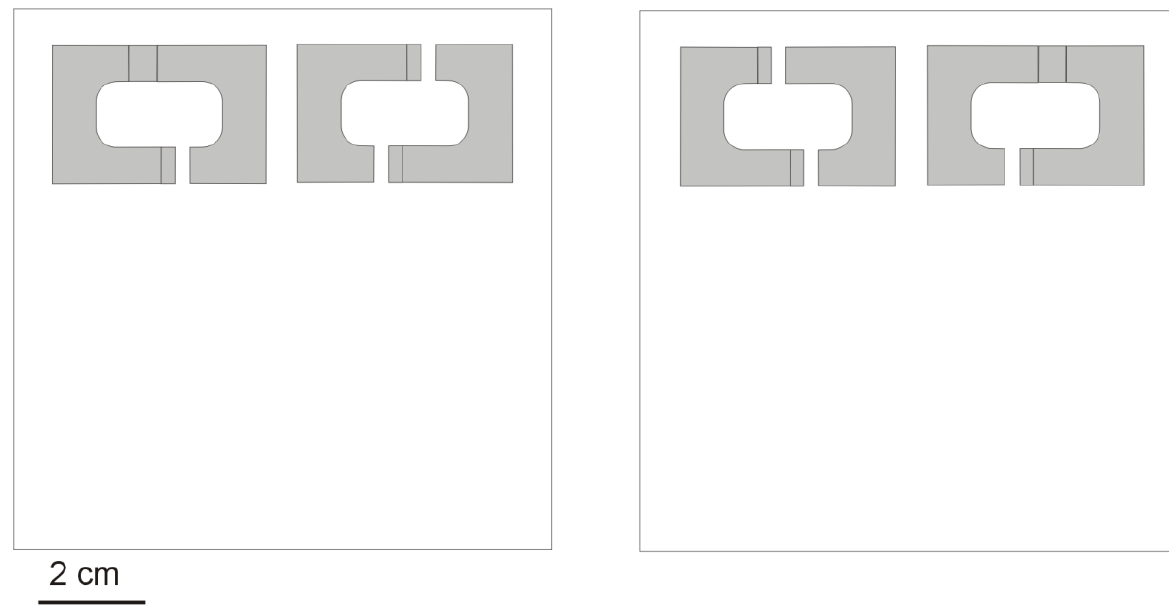
Figure 4. Scheme of the laboratory experiment. In square Petri dishes (10.2 cm × 10.2 cm × 1.9 cm), two artificial nest sites were placed: one with one entrance and one with two entrances (see Figure 3). The position, i.e., left or right, of the nest sites with one or two entrances was systematically varied in the Petri dishes. The ants were then released at a similar distance from the entrances to the two artificial nest sites, approximately 7 cm from the entrances.